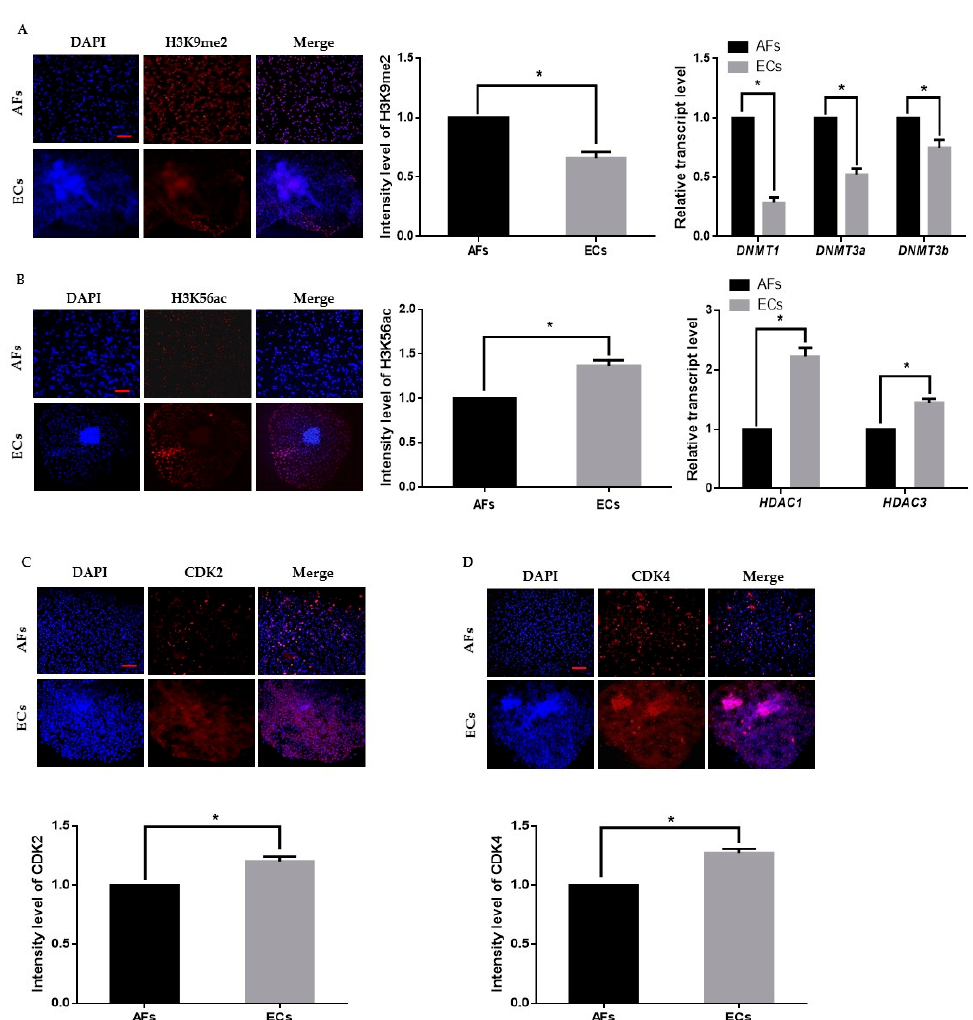
Figure 1. Epigenetic staining of donor cells. ( A ) Representative immunofluorescence images of H3K9me2 in donor cells. Donor cells were stained for H3K9me2 (red) and DNA (DAPI, blue). Bar = 100 µ m. Quantification of fluorescence intensity in donor cells. Quantitative real-time polymerase chain reaction (qRT-PCR) results for DNMTs ( DNMT1 , DNMT3a , DNMT3b ) in donor cells. ( B ) Representative immunofluorescence images of H3K56ac in donor cells. Donor cells were stained for H3K56ac (red) and DNA (DAPI, blue). Bar = 100 µ m. Quantification of the fluorescence intensity in donor cells. Quantitative real-time polymerase chain reaction (RT-qPCR) results for HDACs ( HDAC1 , HDAC3 ) in donor cells. ( C , D ) Representative immunofluorescence images of CDK2 and CDK4 in donor cells. Donor cells were stained for CDK2 and CDK4 (red) and DNA (DAPI, blue). Bar = 100 µ m. Quantification of fluorescence intensity in donor cells. Labeling intensity was expressed relative to that of the AFs (set as 100%). The data are from three independent experiments and are means ± SEM (* p < 0.05).